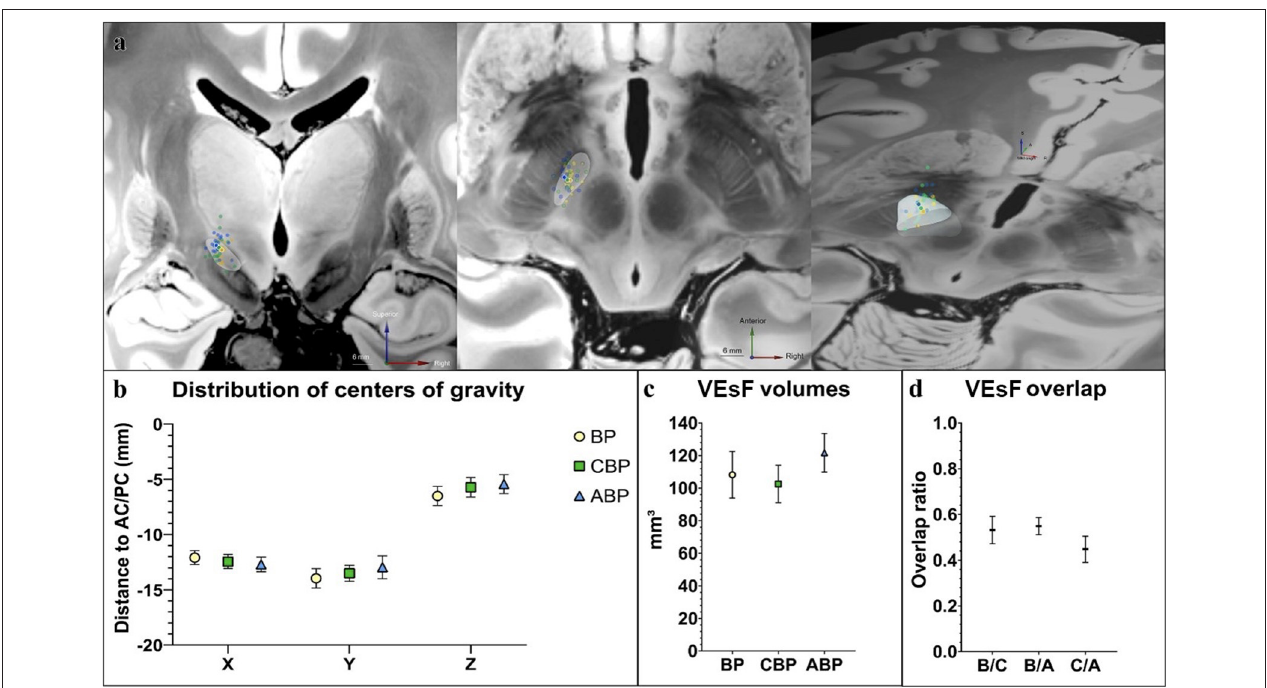
FIGURE 3 | Comparison of stimulation programs by VEsF modeling. (a) Visualization of the COG of all VEsFs displayed on a coronal plane, axial plane, and as oblique bird’s eye view on a normalized 7T-FLASH-sequence (yellow dots, BP VEsFs; green dots, CBP VEsFs; blue dots, ABP VEsFs, the mean COG of each group is highlighted with a white outline). (b) overview of the distribution of COG. (c) VEsFs volumes. (d) VEsF overlap between individual groups. ABP, anatomical-based programming; BP, baseline program; CBP, clinical-based programming; COG, centers of gravity; VEsF, Volumes of the electrostatic